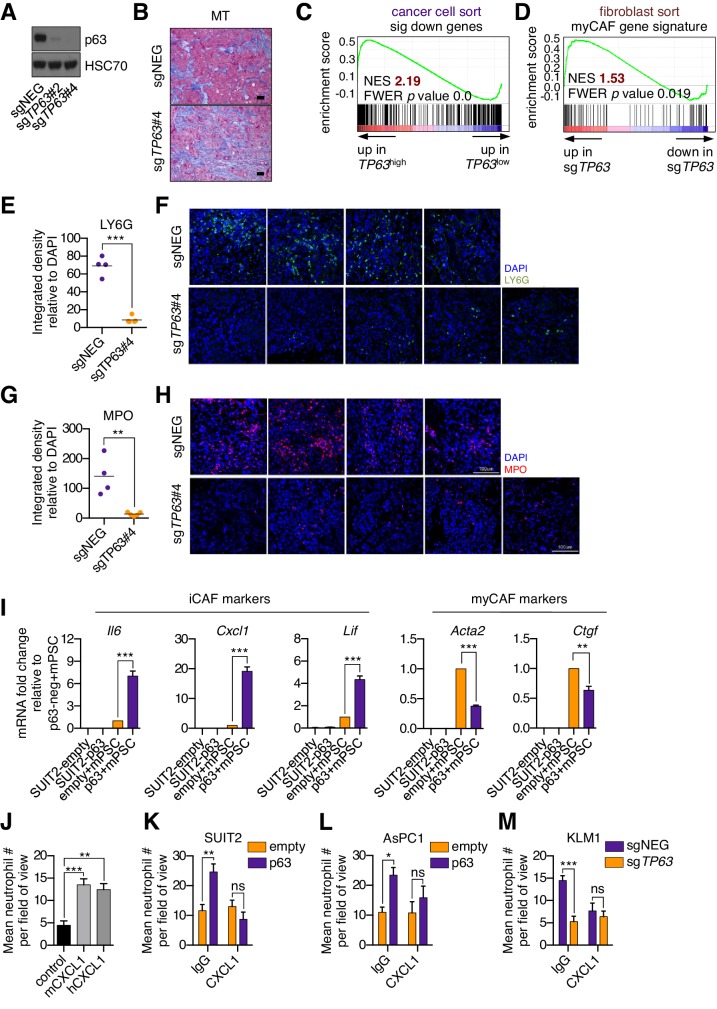
Knockout of p63 in an orthotopic PDA tumor model attenuates the inflammatory signature of fibroblasts and immune cells.(A) Western blot analysis for HSC70 and p63 in the KLM1-Cas9 cells following p63 knock out with CRISPR. (B) Representative images from Figure 4D. Scale bar indicates 50 μm. MT, Masson’s trichrome. (C) GSEA plot evaluating the 459 significantly down-regulated human genes based on their expression in TP63high versus TP63low PDA patient samples from the study by Bailey et al. (2016). Patients were designated as TP63high or TP63low as described in Somerville et al. (2018). (D) GSEA plot evaluating the myCAF signature in FACS-purified fibroblasts from p63-positive (sgNEG) or p63 knockout tumors. (E–H) Quantification of LY6G (E) and MPO (G) expression as determined by immunofluorescence staining of tumors from the indicated experimental groups. n = 4–5 mice per group. ***p<0.001, **p<0.01 by Student’s t-test. Representative images for LY6G (F) and MPO (H) are shown. Scale bar indicates 100 μm and applies to all images. (I) Bar charts show RT-qPCR analysis for the iCAF markers (Il6, Cxcl1, Lif; left panel) and myCAF markers (Acta2, Ctgf; right panel) in the indicated culture conditions. Mean+ SEM is shown. n = 3. ***p<0.001, **p<0.01 by Student’s t-test. (J) Quantification of trans-well neutrophil migration stimulated by murine (mCXCL1) or human CXCL1 (hCXCL1) as determined by confocal imaging. These experiments were performed alongside the SUIT2-empty or SUIT2-p63 cells co-culture experiments shown in the main figure as positive controls. Mean+ SEM is shown. Results are presented as the mean number of invading neutrophils per 10 random fields for each condition and are representative of n = 3 biological replicates. ***p<0.001, **p<0.01 by two-way ANOVA with Sidak’s test for multiple comparisons. (K–M) Conditioned media was harvested from SUIT2-empty or SUIT2-p63 cells (K), AsPC1-empty or AsPC1-p63 cells (L), or KLM1-Cas9 cells infected with sgRNAs targeting TP63 or a control sgRNA (sgNEG) (M) after four days and used for trans-well migration assays with freshly isolated mouse neutrophils in the presence of a CXCL1 blocking antibody or IgG control. Bar charts show quantification of trans-well neutrophil migration in the indicated media conditions as determined by confocal imaging. Mean+ SEM is shown. n = 3. ***p<0.001, **p<0.01, *p<0.05 by two-way ANOVA with Sidak’s test for multiple comparisons. ns, not significant.